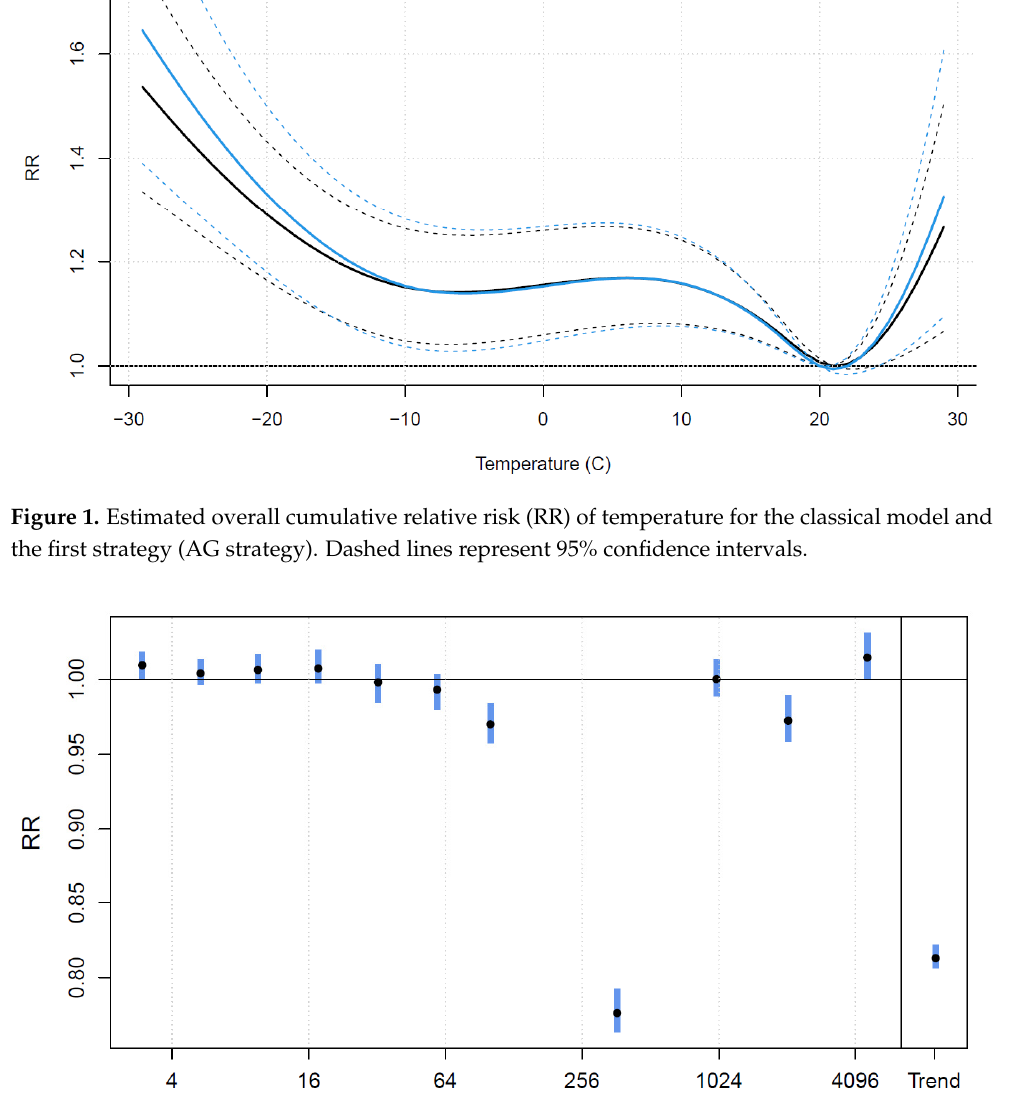
Figure 3. Estimated overall relationship between the cardiovascular mortality and temperature across the year. Dashed lines indicate 95% confidence intervals. This overall relationship is obtained by summing the functional coefficient along the lag dimension. Note that the seemingly low values of the relative risk (RR) are explained by its continuous nature (the relationship is spread across the whole curve). Figure 4 shows the strategy FD results, i.e., the estimated RR associated to the previ- ous day temperature during summer. The functional is the highest during morning and